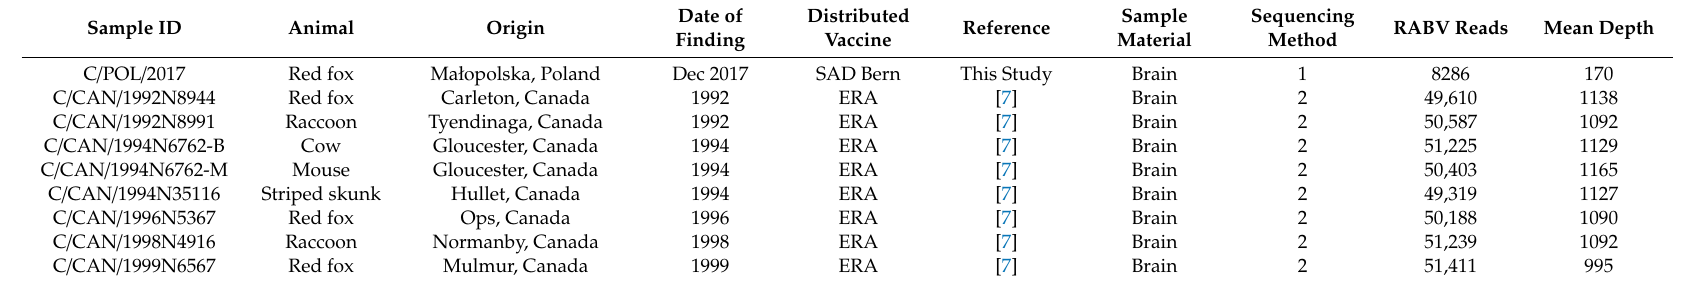
Table 1. Overview of additional vaccine-induced rabies cases from Poland and the Ontario province of Canada analyzed in this study.